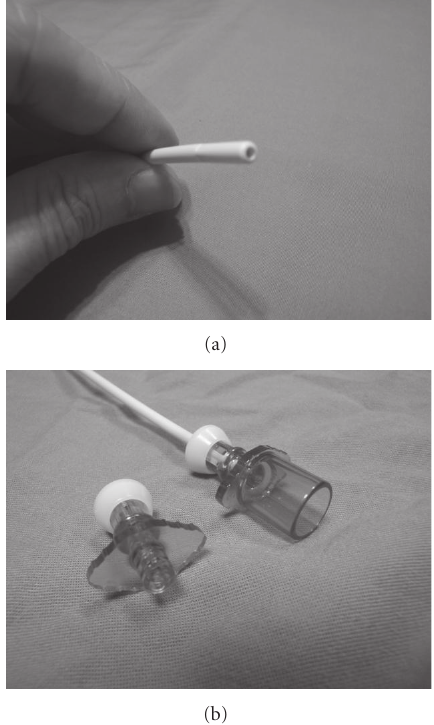
Figure 1: (a) Center hollow channel. (b) Adaptors for oxygen insu ffl ation or jet